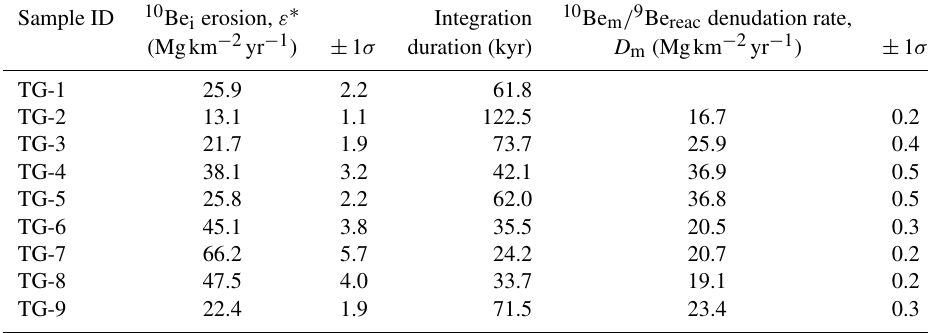
Table 5. 10 Be i -based erosion rates and 10 Be m / 9 Be reac -based denudation rates. Sample ID 10 Be i erosion, ε